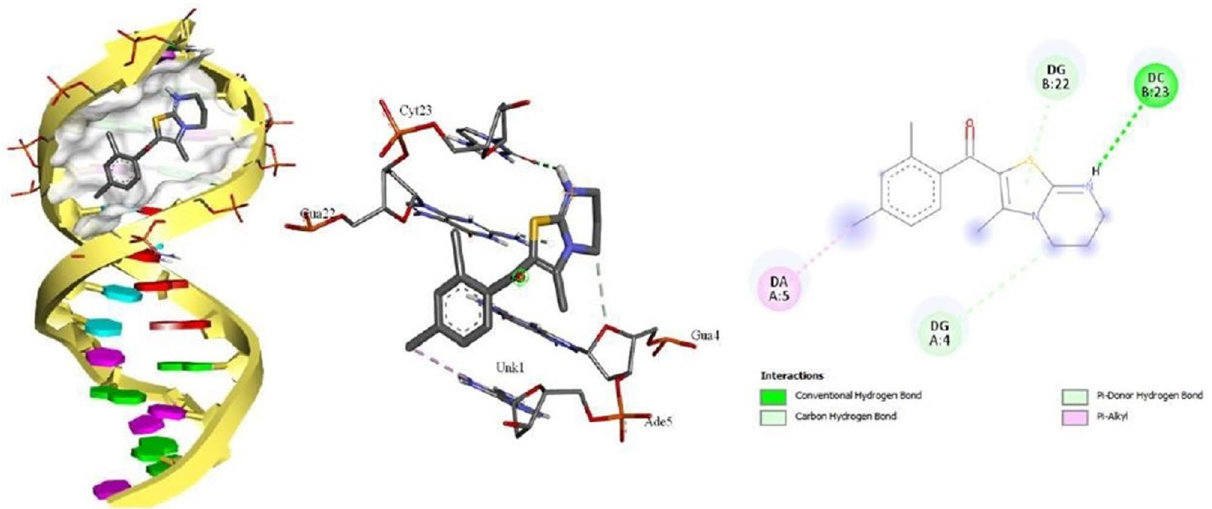
Figure 6. Docking pose of compound 4g and interactions with ct-DNA. The figure was generated using BIOVIA Discovery Studio Visualizer (DSV) (https:// disco ver. 3ds. com/ disco very- studio- visua lizer- downl